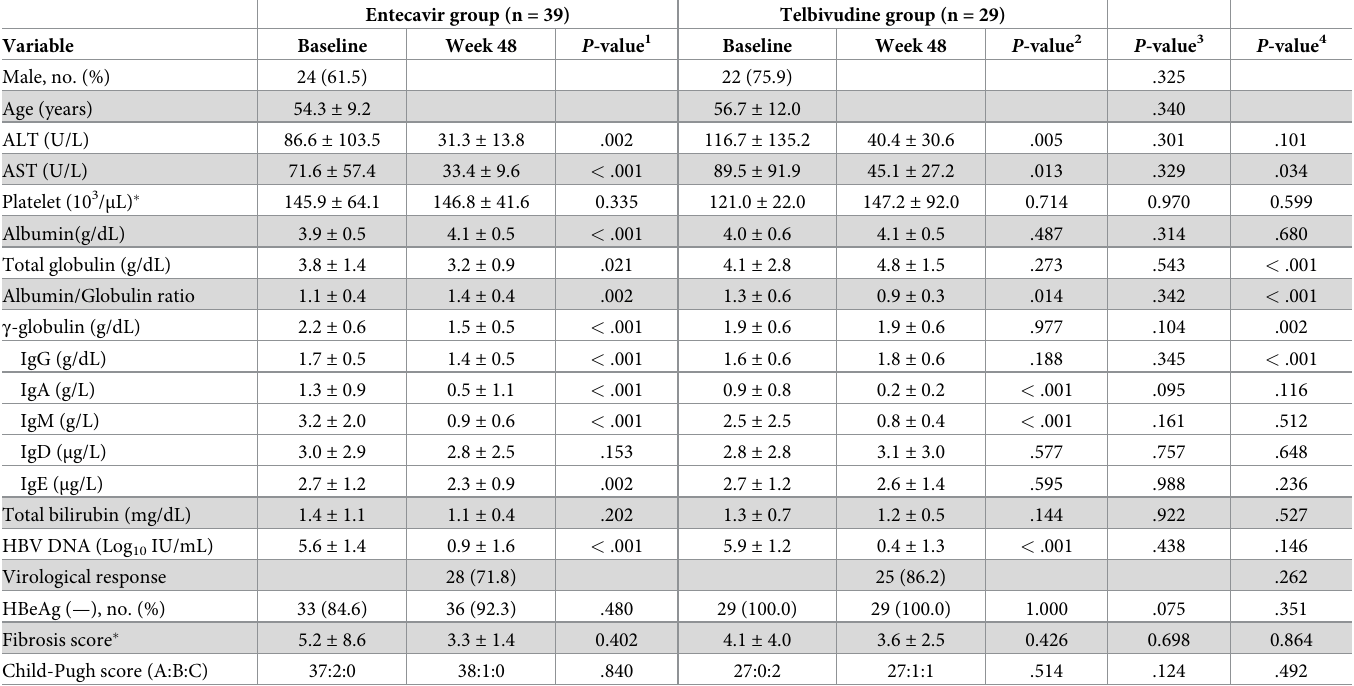
Table 1. Clinical data of patients with HBV-related liver